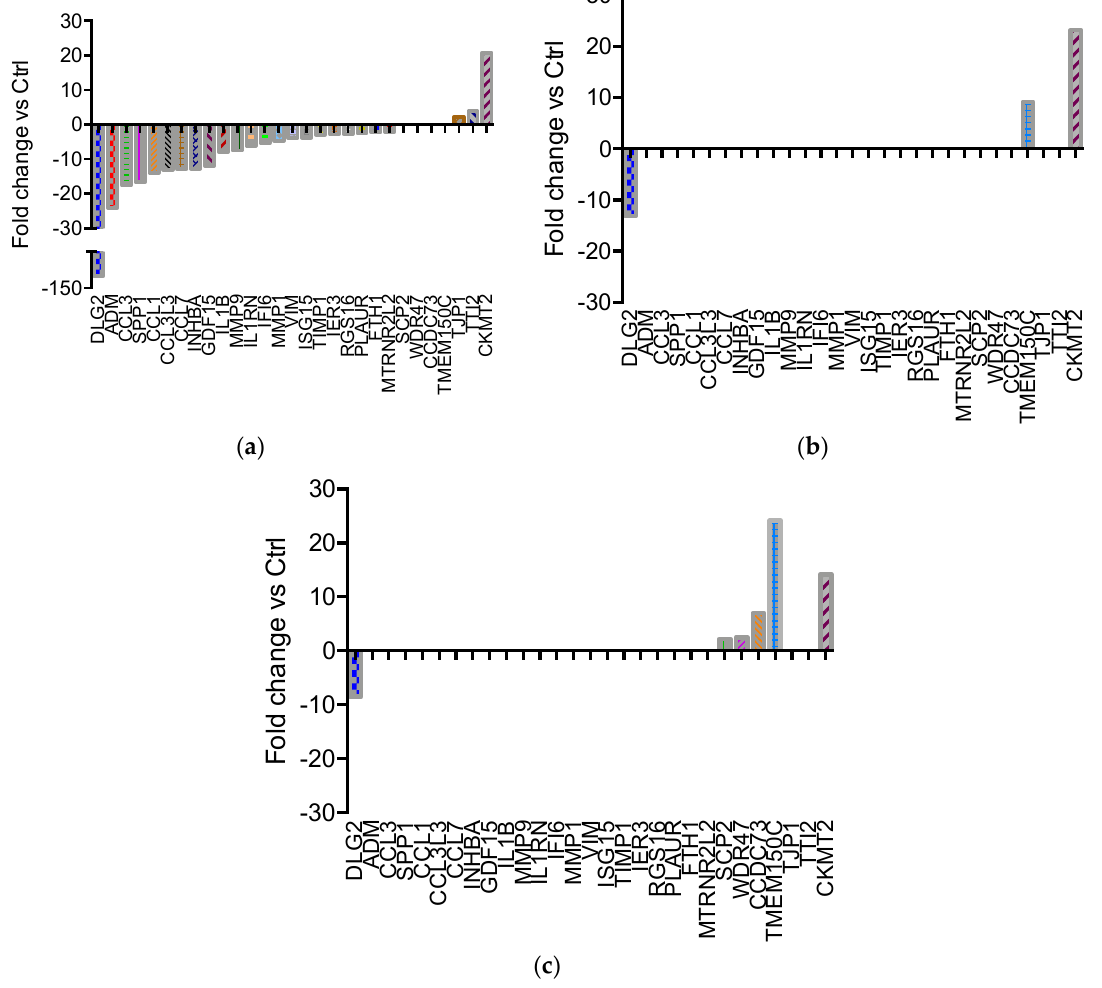
Figure 1. Differentially expressed genes in U937 cells treated with lysozyme 15 μ g/mL for 1 h and analysed immediately at the end of the treatment (1 h, a ) or 2 h after the end of the treatment (1 h + 2, b ), or treated for 24 h and analysed immediately at the end of the treatment (24 h, c ). Fold change values in respect of parallel control samples are shown in ascending order. Complete gene expression data is available in Supplementary Table S1.